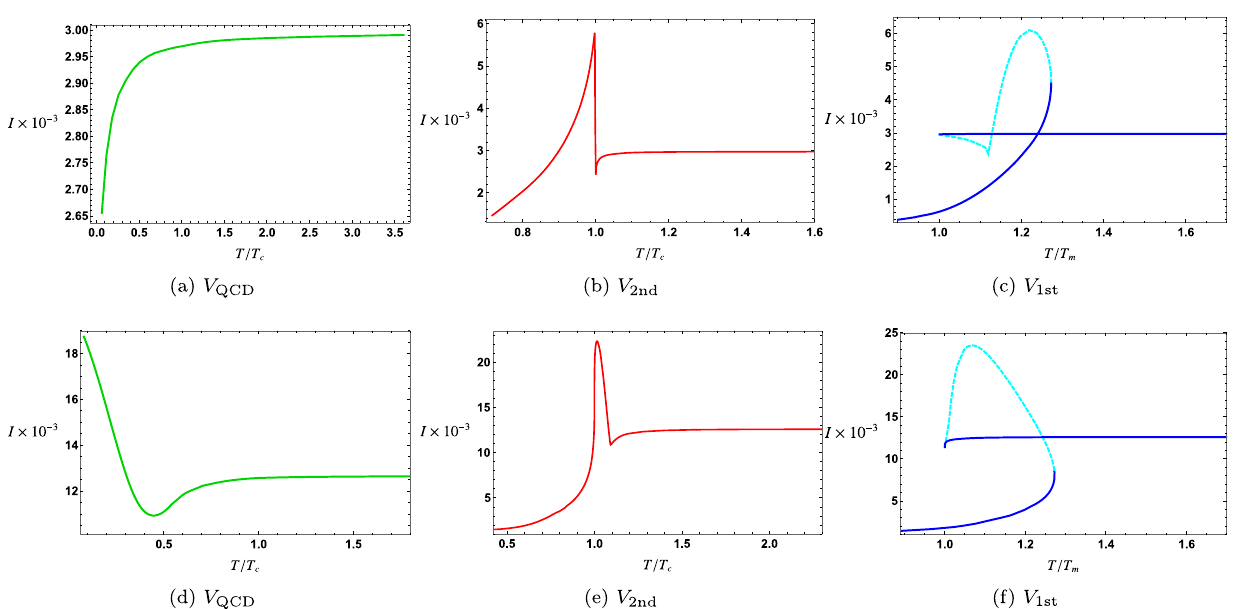
Fig. 8 Top row: The HMI v.s. temperature T for the dilaton poten- tials V QCD (left), V 2nd (middle) and V 1st (right) for fixed l = 0 . 05 and l (cid:3) = 0 . 01. Bottom row: The HMI v.s. temperature T for the dilaton potentials V QCD (left), V 2nd (middle) and V 1st (right) for fixed l = 0 . 05